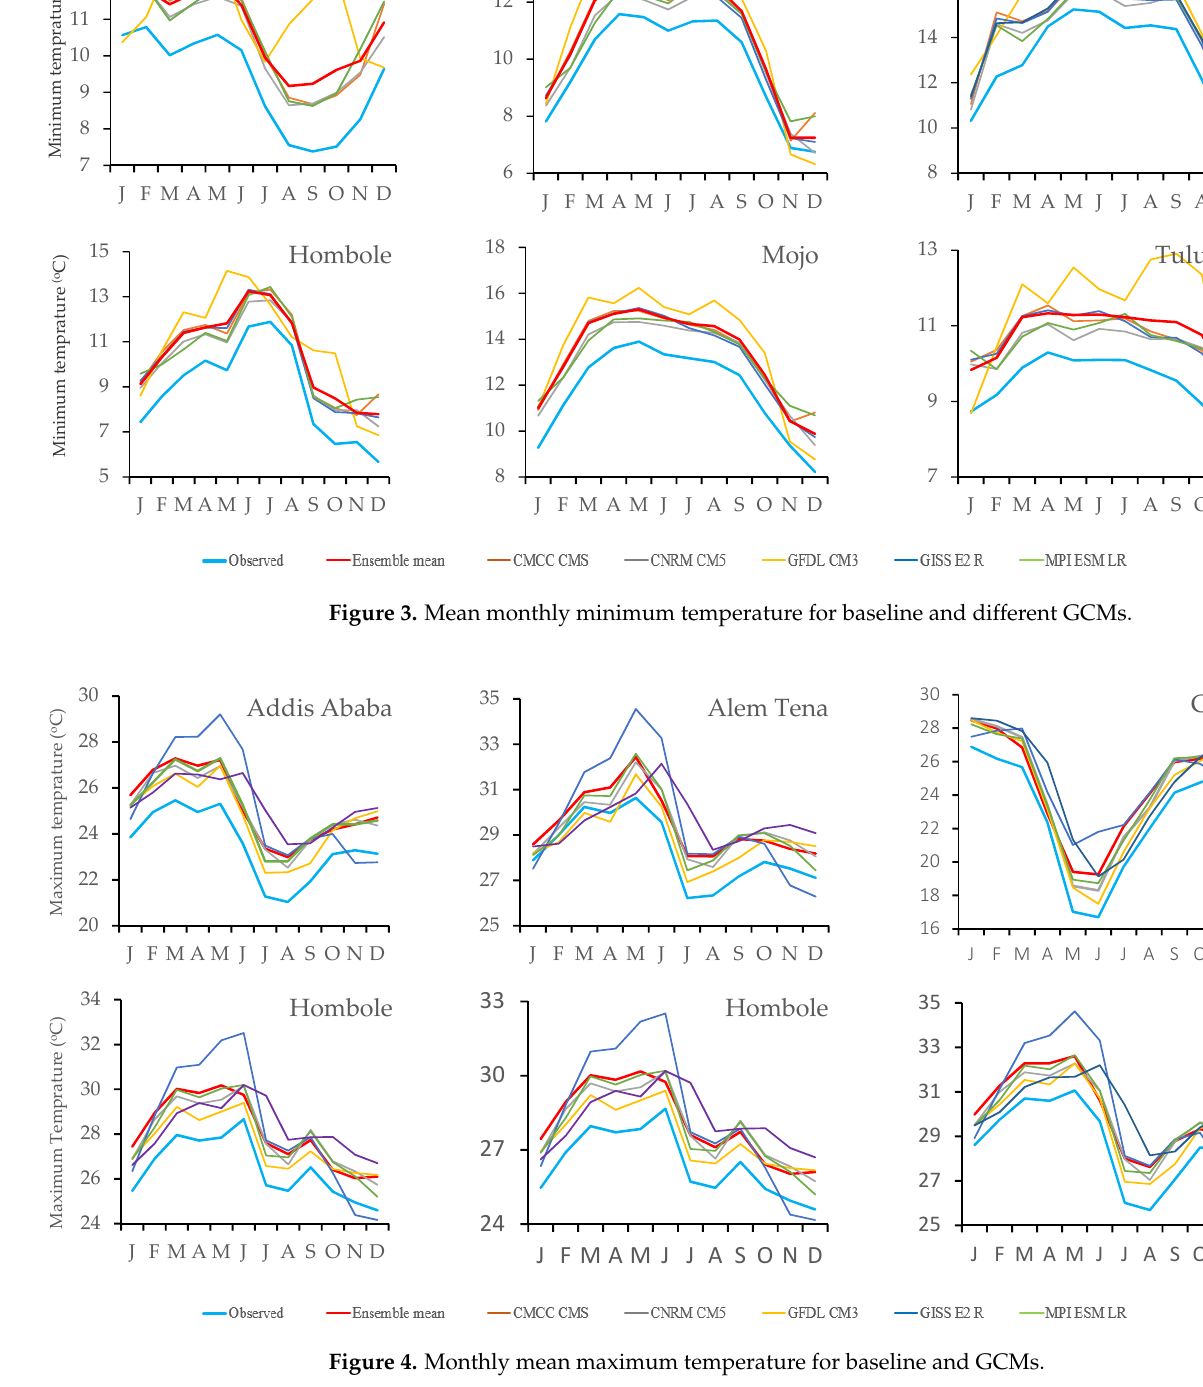
Figure 4. Monthly mean maximum temperature for baseline and GCMs.